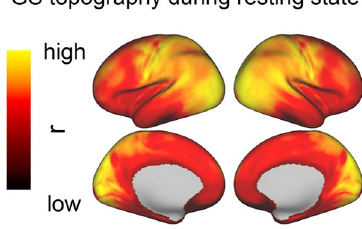
Fig. 1 GS topography during resting state. A reliable relationship between GS and cortical regions has been observed across various studies 10,17,19 – 22,41 – 44 . In general, the primary sensory regions (i.e., sensorimotor and visual cortex) show higher correlations with GS (as indicated by the more yellow color), and the higher-order cortical regions show low correlations with GS (as indicated by the red